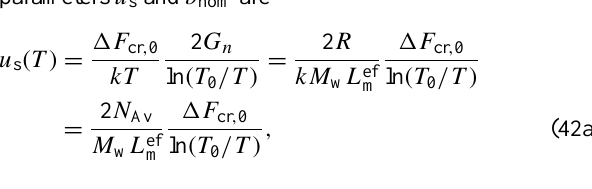
Fig. 7. General features of homogeneous ice nucleation kinetics (evolution of water and ice supersaturations and crystal concentration) illustrated with a parcel model run with the parameters: initial temperature T c = -40 ° C, s w ( t = 0) = -0.1 (-10 %), lognormal size spectrum of haze particles with mean geometric radius of 0.02 µ m and concentration N a = 200 cm -3 . The symbols t cr, 1 and t cr, 2 (marked with ellipses) denote the 1st and 2nd times when critical (threshold) ice supersaturations s i,cr 1 and s i,cr 2 are reached, that is, the start and end of nucleation; t max is the time when maximum ice and water supersaturations s i,max , s w,max are reached; s w,cr denote the curves of critical (threshold) water and ice supersaturations. The point denoted by ellipse on the curve N c ( t ) with the symbols s i,max , s w,max is the point at t max where maximum s w and s i are reached. The curve N c ( t ) above this point corresponds to ice nucleation at t max < t < t cr, 2 .